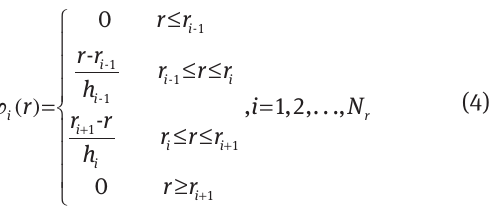
Generally in FGMs, Poisson ’ s ratio ν does not vary considerably with the constituents, so that in this paper a constant Poisson ’ s ratio is assumed, unless otherwise stated. In Eq. (1), E and ρ denote the metallic modulus f f of elasticity and density at the inner surface r , and the in subscript f refers to the metal constituent. Also n and n 1 2 are the power law